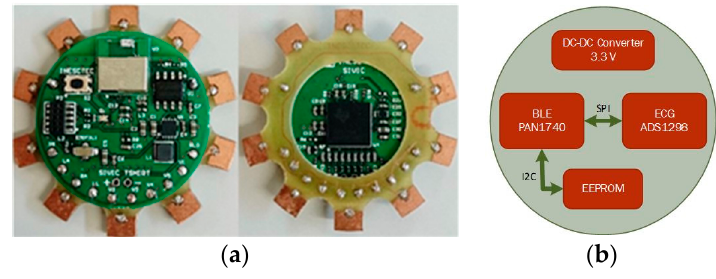
Figure 5. ( a ) Photo of the 12-lead ECG DAT unit (front and back sides); and ( b ) block